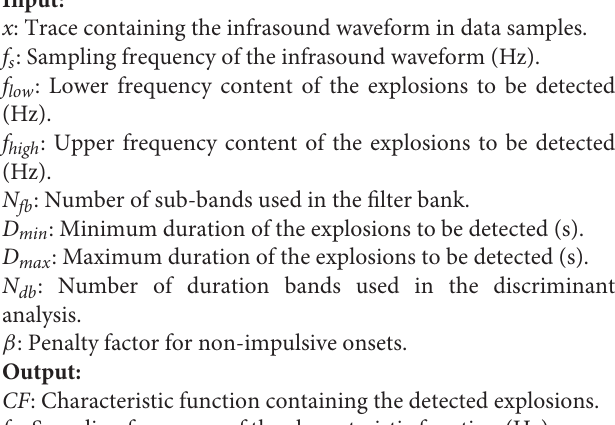
Algorithm 1 VINEDA parameters